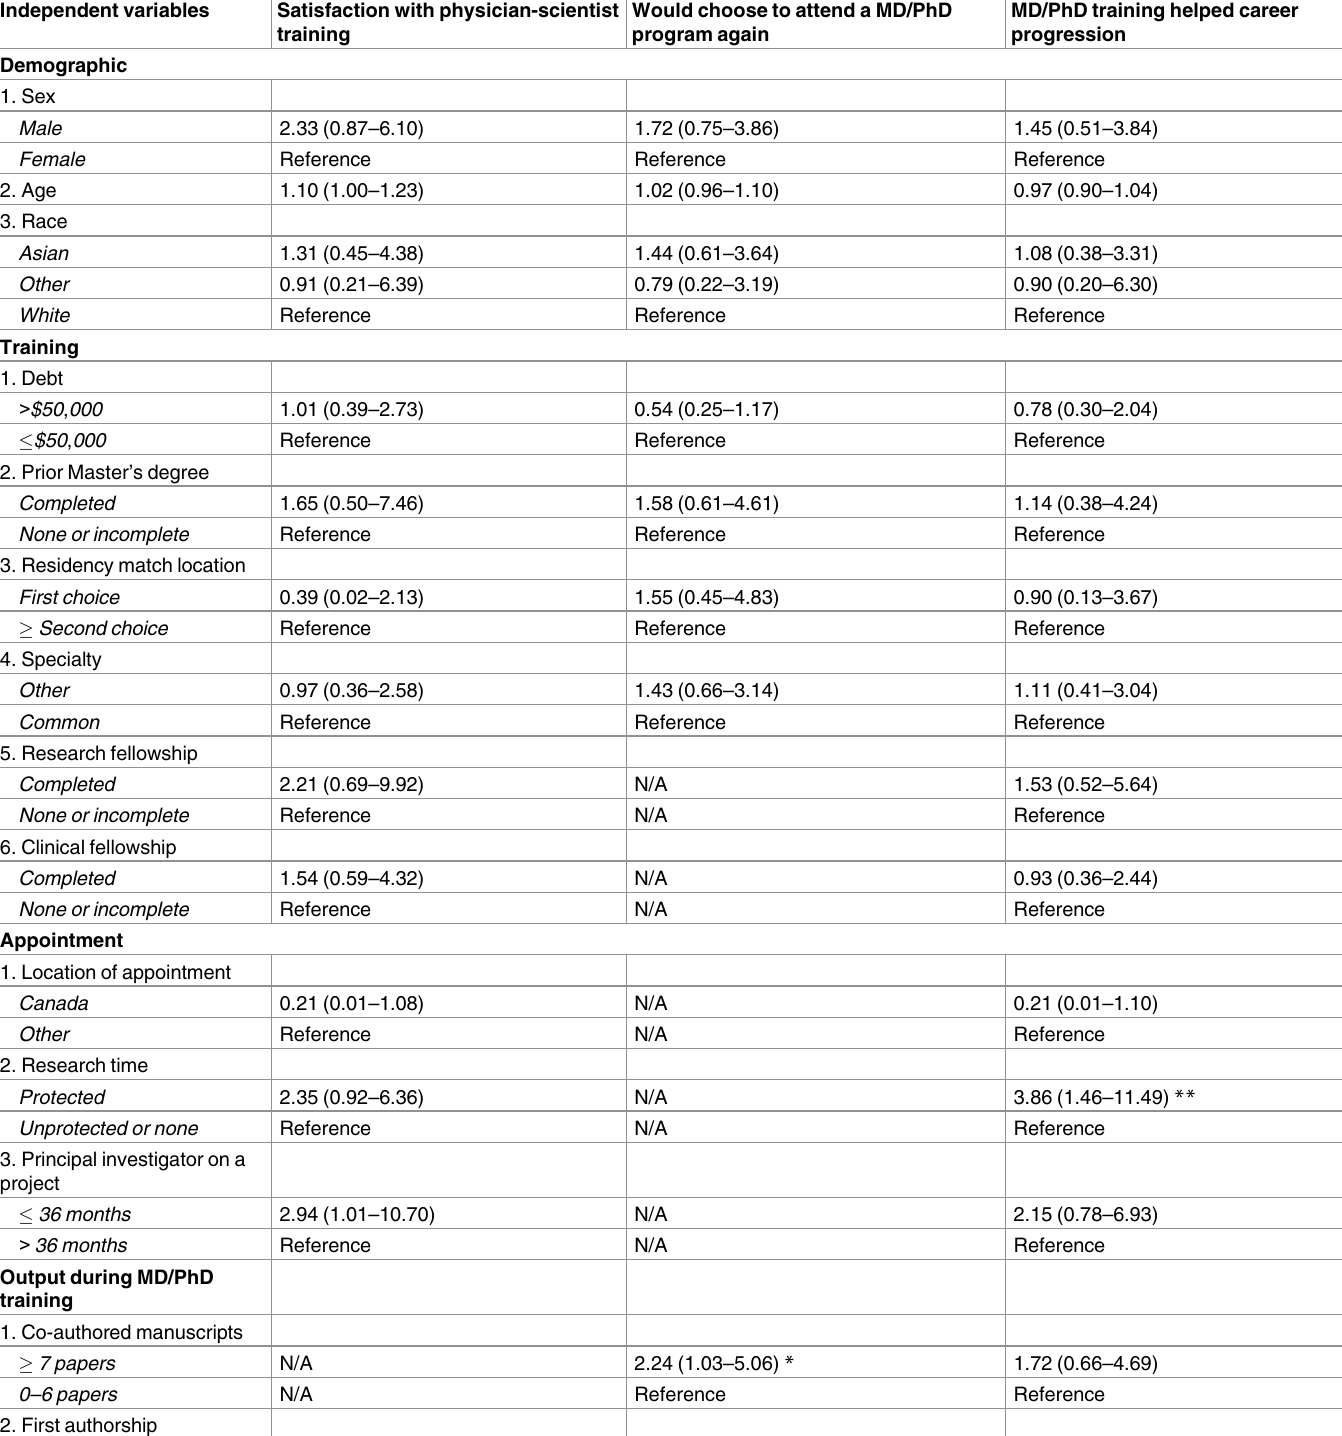
Table 3. Logistic regression for outcome measuresof satisfaction with physician-scientist training and independent variables. Data was derived from the surveyedCanadianMD/PhD alumnicohort (n = 139); data presentedas odds ratio (95% confidenceintervals), and ( * ) P < 0.05; ( ** ) P < 0.01. N/A denotesindependentvariablesthat are not applicable to outcome